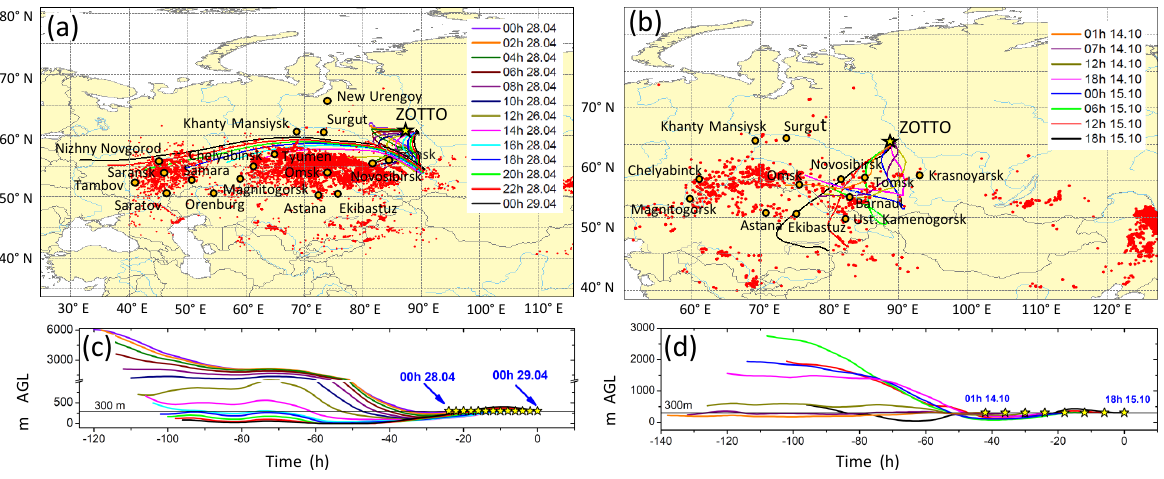
Figure 9. Figure shows 96h HYSPLIT air mass trajectories during spring pollution events at ZOTTO at 300m on 28 April 2011 (a) and 14 to 15 October 2010 (b) and their height above ground level (a.g.l.) (c and d , respectively). Red dots indicate the fire locations (a, b) . Stars and dates show the arrival time of air mass with 2h (a, c) and 6h (b, d) intervals, respectively.